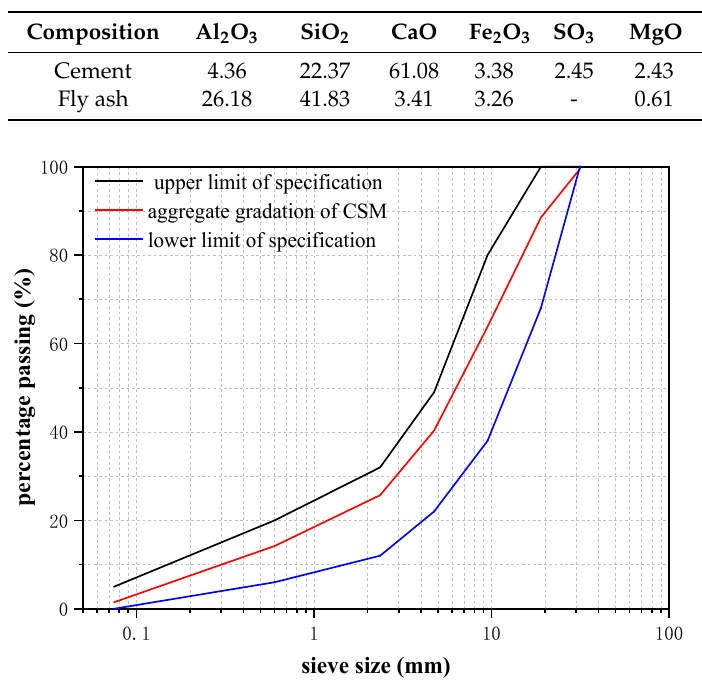
Table 1. Chemical composition of cement and fly ash (wt %).